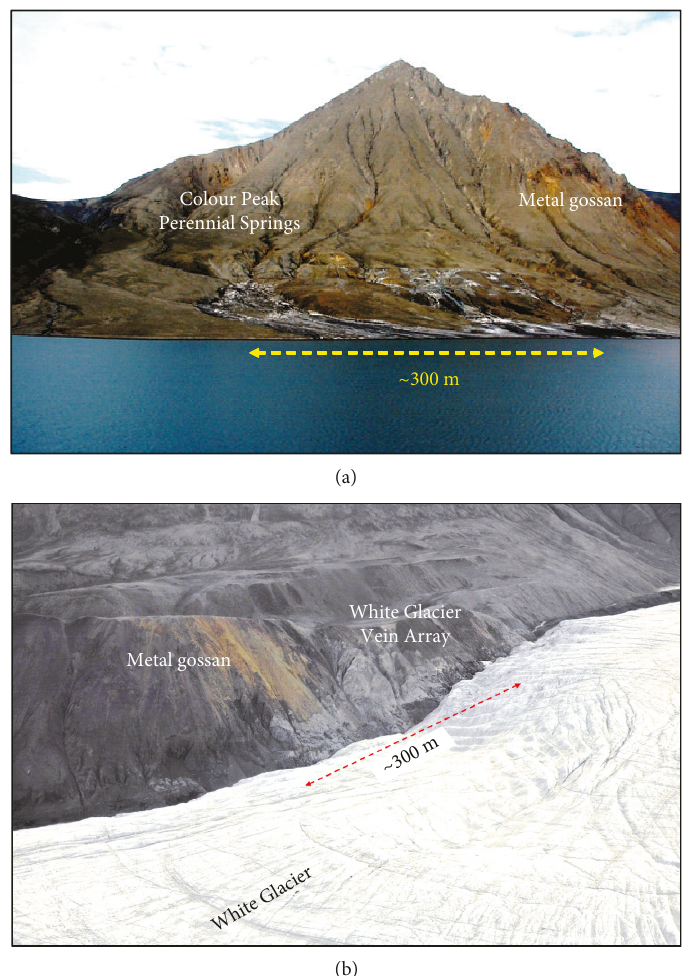
Figure 3: (a) Aerial view of travertine deposits at Colour Peak perennial springs (CPS), northern shore of Expedition Fiord, that emit brines at 6 ° C year-round. The 560m hill is gypsum and anhydrite, but the colourful gossan denotes weathered iron sul fi des associated with rafts of igneous ma fi c rocks. (b) Aerial view of the whitish vein array (WGVA) on the steep fl ank of White Glacier, also associated with a gossan (photo by Dale Andersen). Note the similar scale of the two